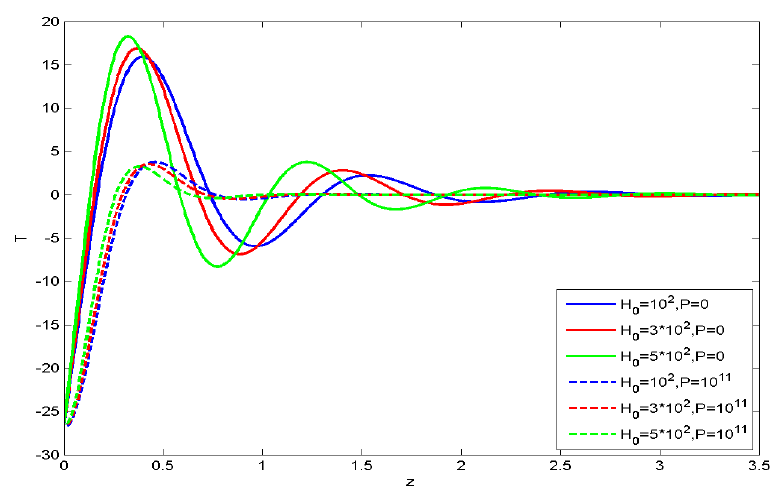
Figure 24. Total stress zzzz στ + concerning z with magnetic field H 0 .